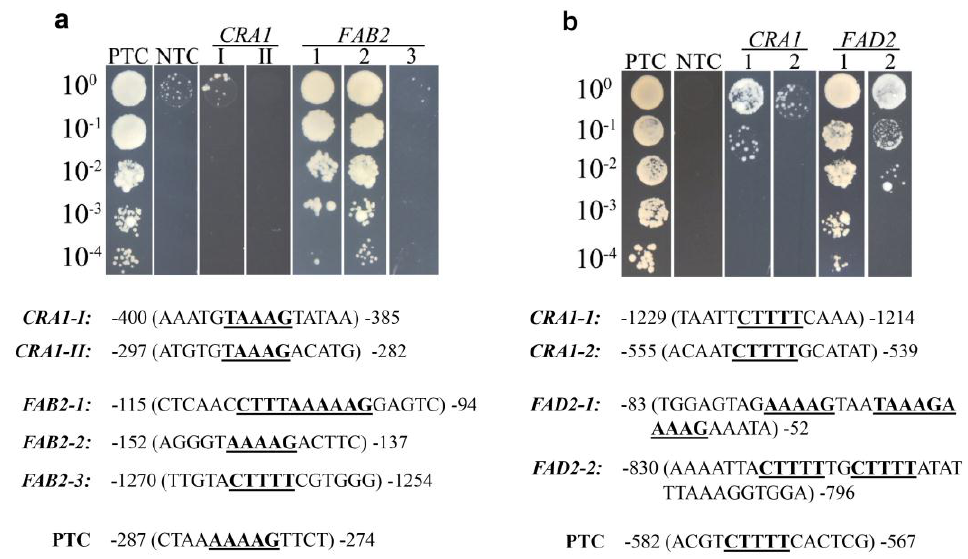
Figure 5. GmDof4 and GmDof11 interact with the cis -DNA elements in the promoter regions of downstream genes in the transgenic plants ( a ) Interaction between GmDof4 and the cis -DNA elements in the promoter regions of CRA1 and FAB2 . The bolded and underlined sequences indicate the core sequence of the Dof-binding elements. The putative Dof-binding elements were cloned into pAbAi, and these plasmids were transfected into yeast Y1HGold cells with pGADT7- GmDof4 . Growth of the transfected yeast cells on the SD/-Leu/-Ura + AbA (0.2 mg/L) plates indicates that GmDof4 protein can bind to its corresponding cis -DNA element. PTC is a strain that contains pGADT7- GmDof4 and a pAbAi plasmid with an element in the promotor region of AtaccD , which was confirmed to interact with the GmDof4 protein. NTC is a strain that contains pGADT7- GmDof4 and an empty pAbAi plasmid. ( b ) Interaction between GmDof11 and the cis -DNA elements in the promoter regions of CRA1 and FAD2 . The bolded and underlined sequences indicate the core sequence of the Dof-binding elements. The putative Dof-binding elements were cloned into pAbAi, and these plasmids were transfected into yeast Y1HGold cells with pGADT7- GmDof11 . Growth of the transfected yeast cells on SD/-Leu/-Ura + AbA (0.2 mg/L) plates indicates that the GmDof11 protein can bind to its corresponding cis -DNA element. PTC is a strain that contains pGADT7- GmDof11 and a pAbAi plasmid with an element in the promotor region of AtCRA1 , which was confirmed to be interacting with GmDof11 protein. NTC is a strain that contains pGADT7- GmDof11 and an empty pAbAi plasmid.